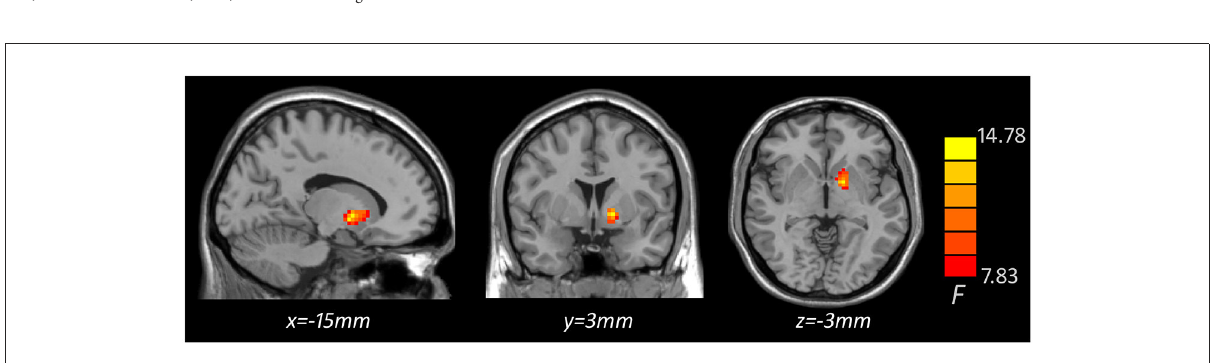
TABLE 3 Brain region showing significant structural difference among three groups ( p < 0.05, GRF corrected ). Brain region